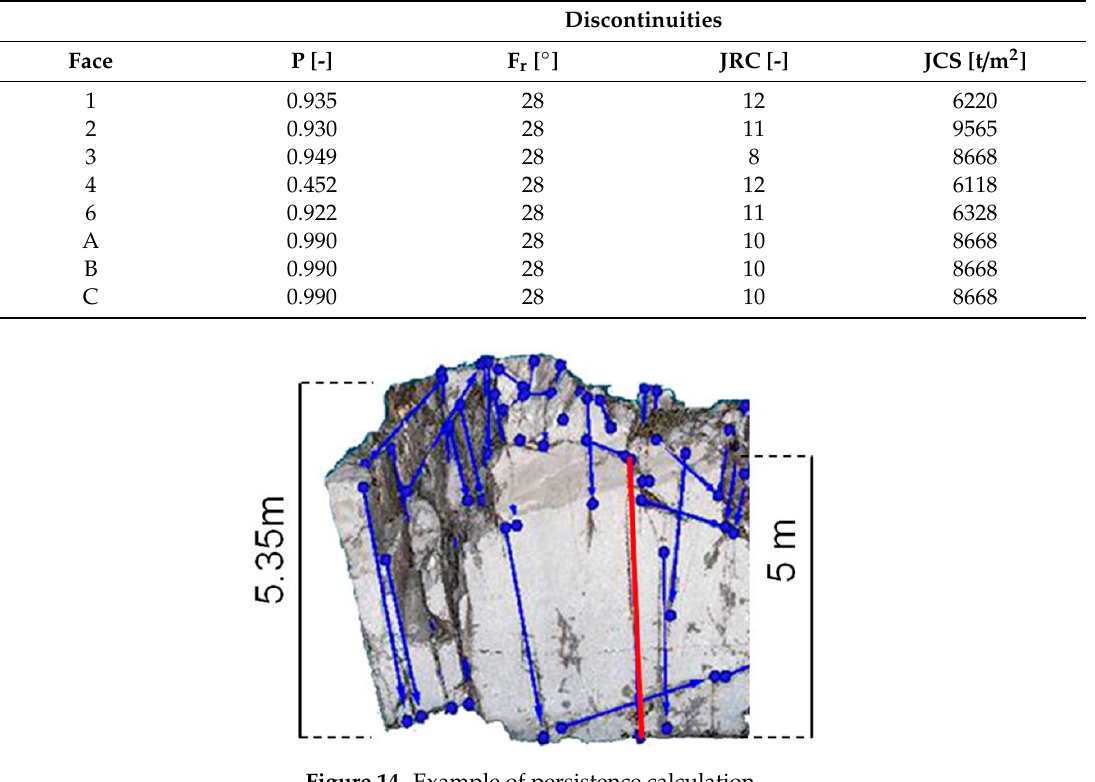
Table 5. Geotechnical parameters used for calculating FoS.